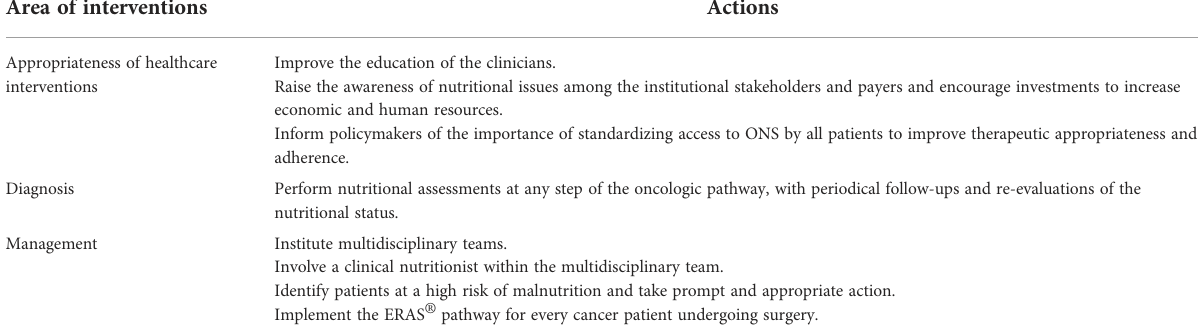
TABLE 2 Summary of practical recommendations to address critical issues in the clinical nutrition management of cancer patients. Area of